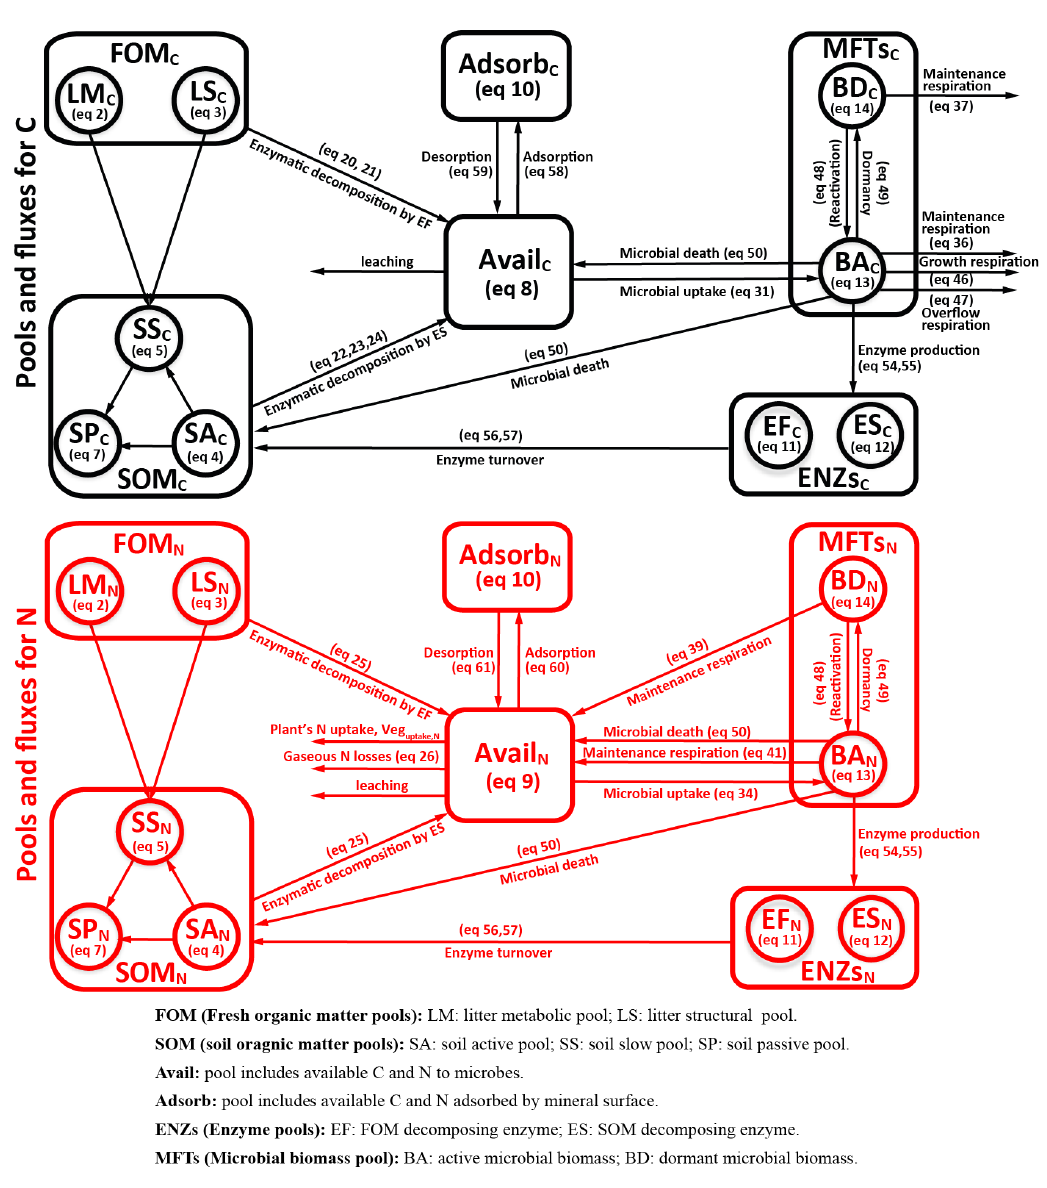
Figure 1. Model structure of the ORCHIMIC model. Rectangles and circles represent pools and arrows represent fluxes for Carbon (C; black) and Nitrogen (N; red). The C and N pools are described in Sect. 2.2. Equations describing the dynamics of each pool and the fluxes are shown in brackets in the figure and can be found in more detail in Sect. 2.2 and 2.3. Arrows between the FOM and SOM pools and within the SOM pools represent fluxes due to physicochemical protection by mineral association and microaggregate occlusion. Veg uptake , N is uptake of N by plants and is not explicitly simulated by